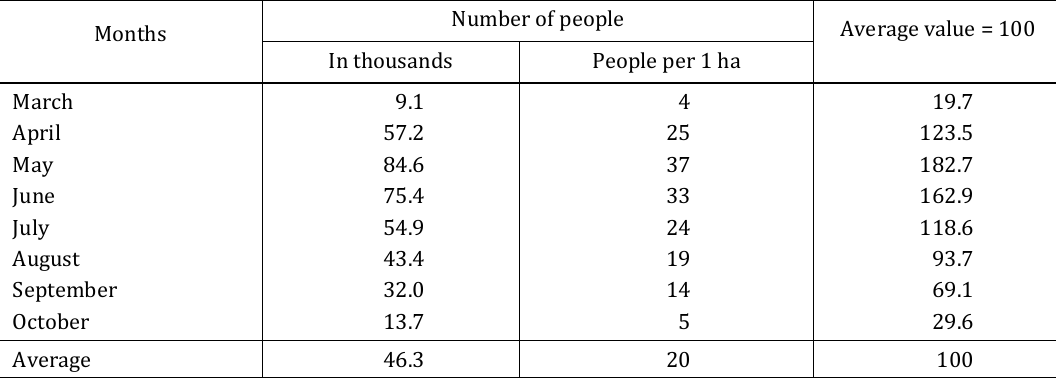
Table 2. Average daily number of people spending the leisure time in allotment gardens in the cities of the Katowice